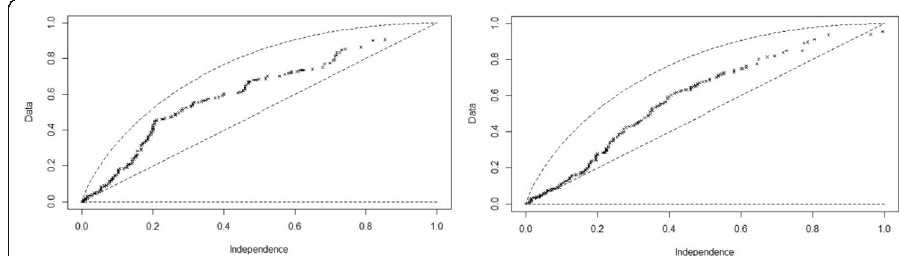
Fig. 3 Kendall-plots for Bitcoin ’ s return and volume with Standardized Google Searching Value extracting from R